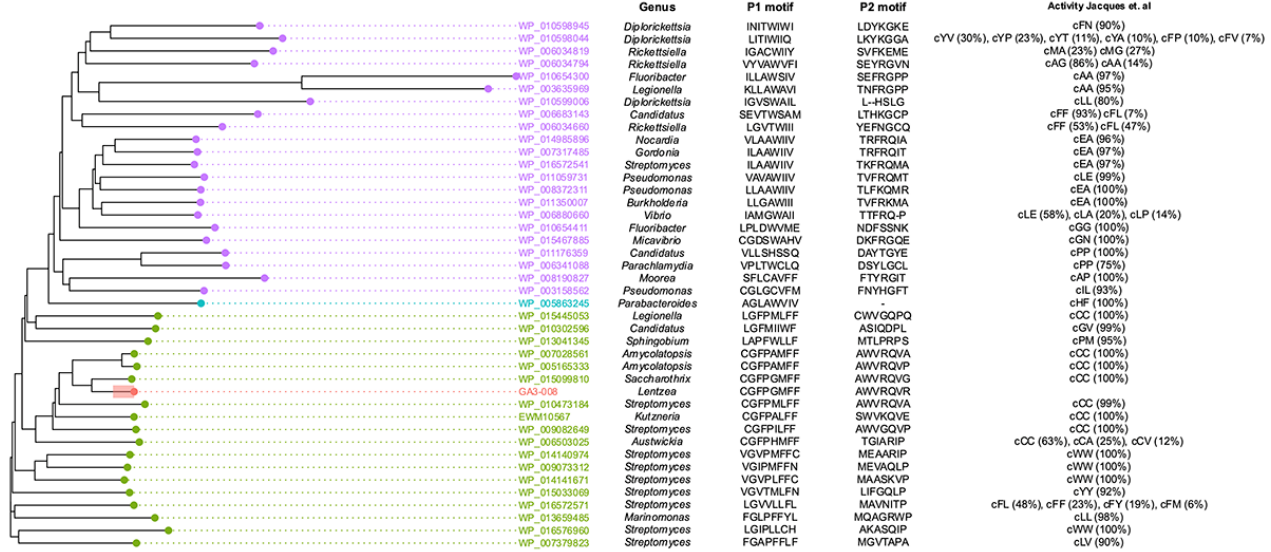
Figure 4. Specificity of CDPS (KOEHFPPE_07267) in Lentzea sp. GA3-008. Right panel shows phylogenetic tree of previously characterized CDPS with their accession numbers. The tree is colored according to the previously reported phylogenetic sub-families of CDPS (purple = XYP, green = NYH, blue = SYQ). KOEHFPPE_07267 from GA3-008 is highlighted in red. P1 and P2 motif corresponds to the amino acid residues in amino acyl t-RNA binding pocket one or two, respectively [9]. Activity data demonstrating amino acid specificity is derived from Jacques et al. [24].